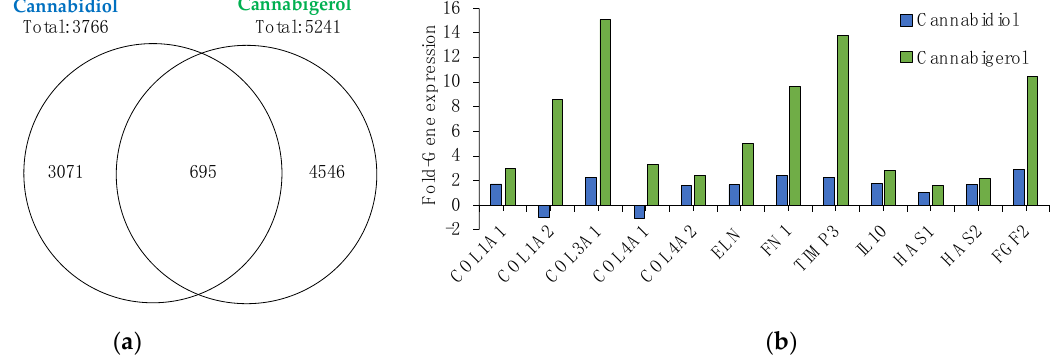
Figure 1. Gene microarray analysis of CBG and CBD. ( a ) Gene differential expression was quantified using Clariom™ S assay microarray system method after 24 h incubation in 3D skin model EpiDerm-FT™. ( b ) Data subset of gene expression related to skin. Data represent mean from n = 3 tissues. All genes shown were significantly different ( p value < 0.05) relative to vehicle-only treated tissues.